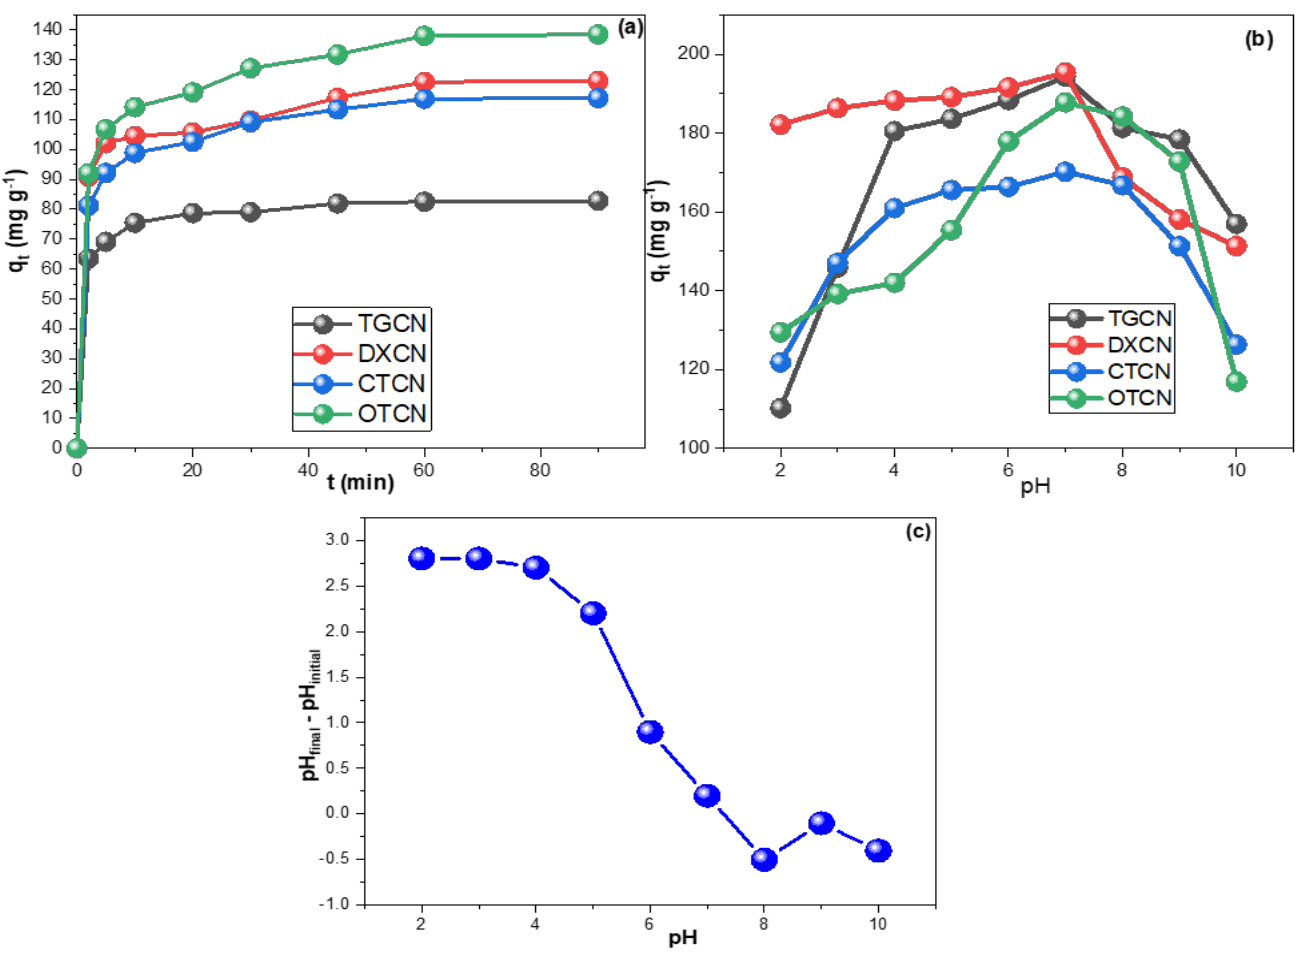
Figure 3. ( a ) The contact time study for the adsorption of TGCN, CTCN, OTCN, and DXCN on the synthesized CRNPs, ( b ) the influence of the solution’s pH on their sorption, and ( c ) the zero charge investigation for the fabricated CRNPs.